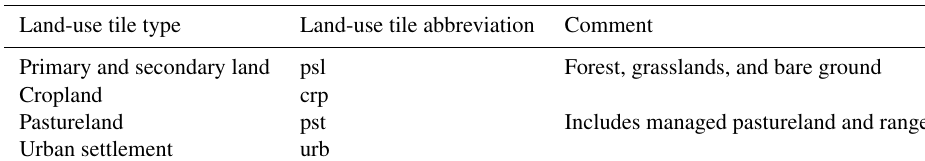
Table 4. Land-use tile types and abbreviations.